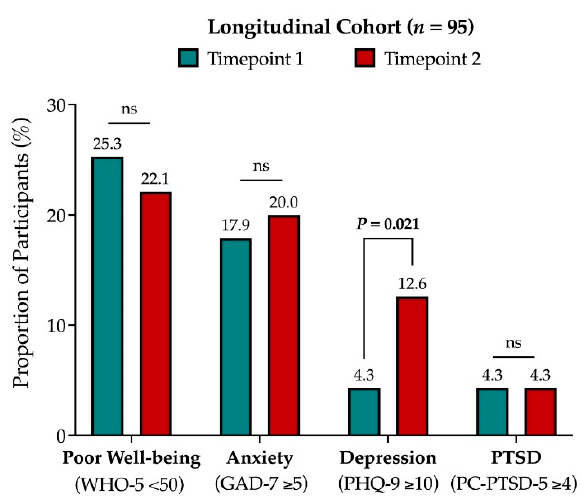
Figure 2. Comparison of the key outcome variables of the PICO-SM study (anxiety, depression, PTSD, and poor wellbeing) for the longitudinal subgroup of n = 95 participants followed-up across two timepoints, 6 months apart. Abbreviation: PTSD, post-traumatic stress disorder; ns, not significant.